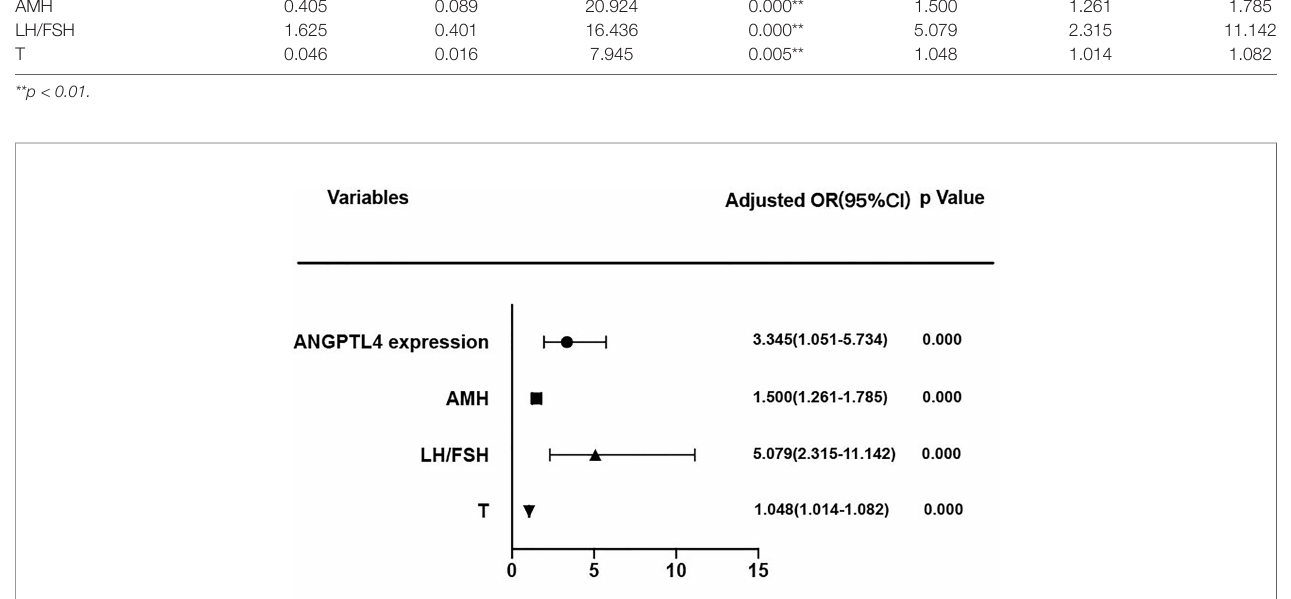
TABLE 4 | Binary logistic repression of PCOS risk factors. Variables B SE Wald p -value OR 95% CI ANGPTL4